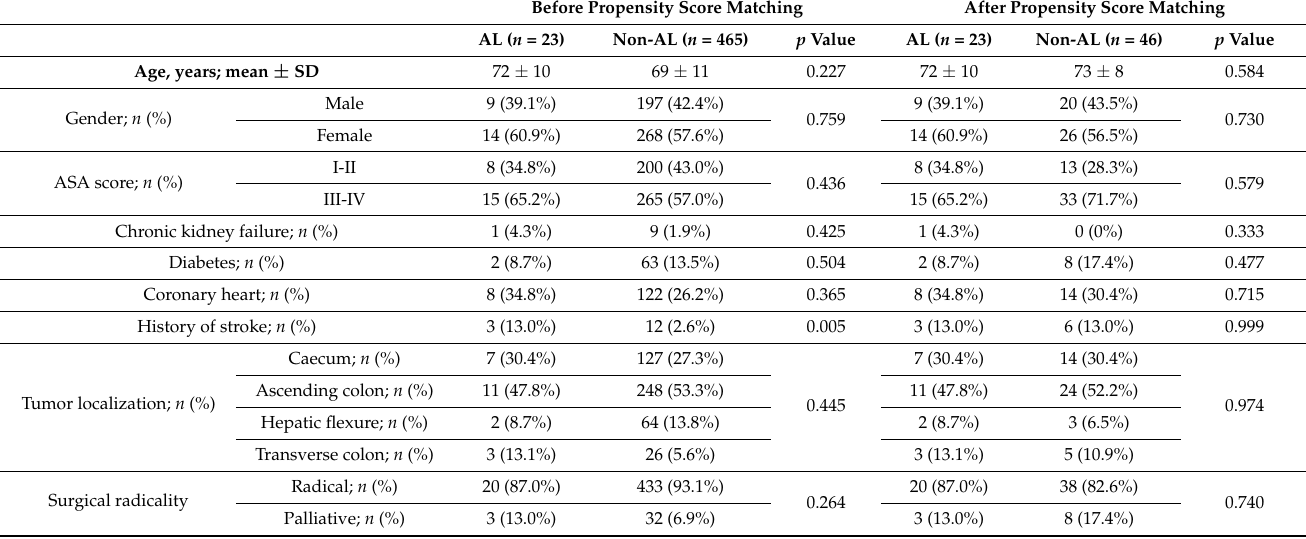
Table 2. Baseline characteristics of patients in the anastomotic leakage and non-anastomotic leakage groups before and after propensity score